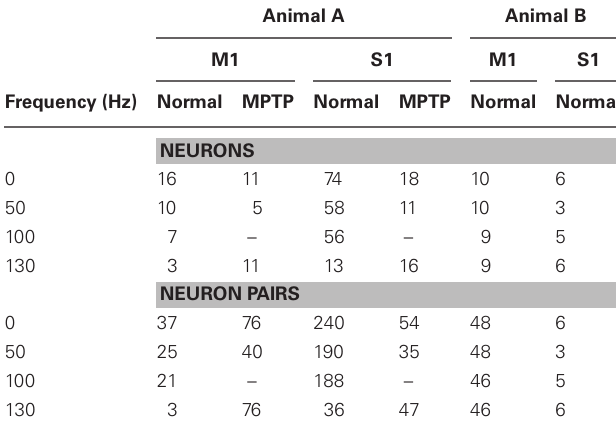
Table 1 | Experimental Data Set. Animal A Animal